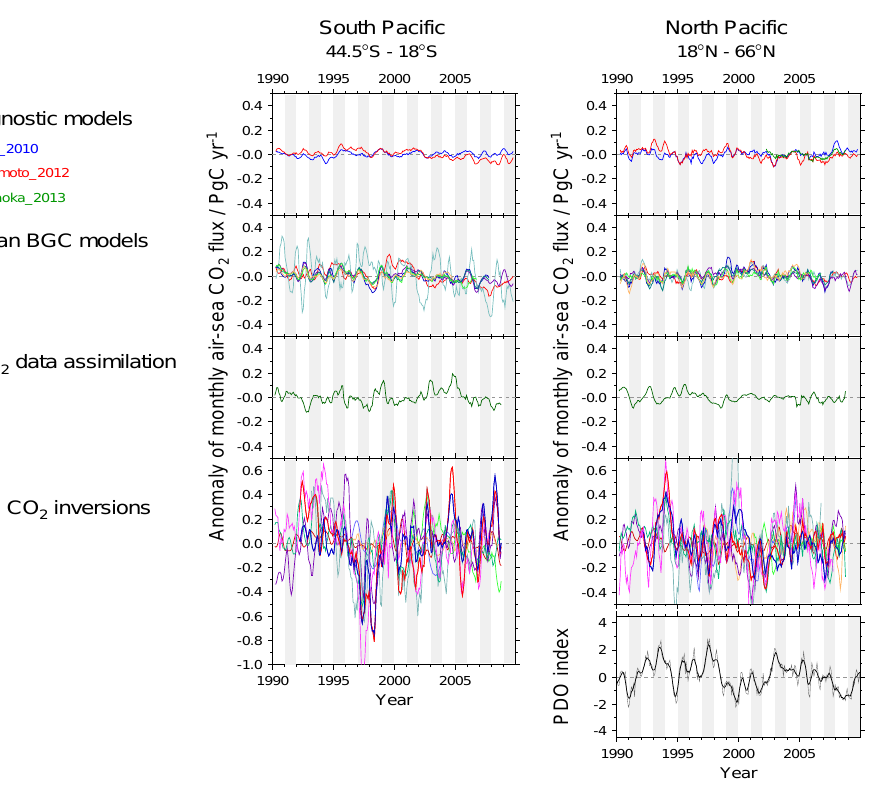
Fig. 8. Trend of air–sea CO 2 flux anomalies (5-month running means) in the South Pacific extratropics (44.5–18 ◦ S) (left) and in the North Pacific extratropics (18–66 ◦ N) (right) for 1990–2009. Also shown at the bottom of right panel is the Index of Pacific Decadal Oscillation